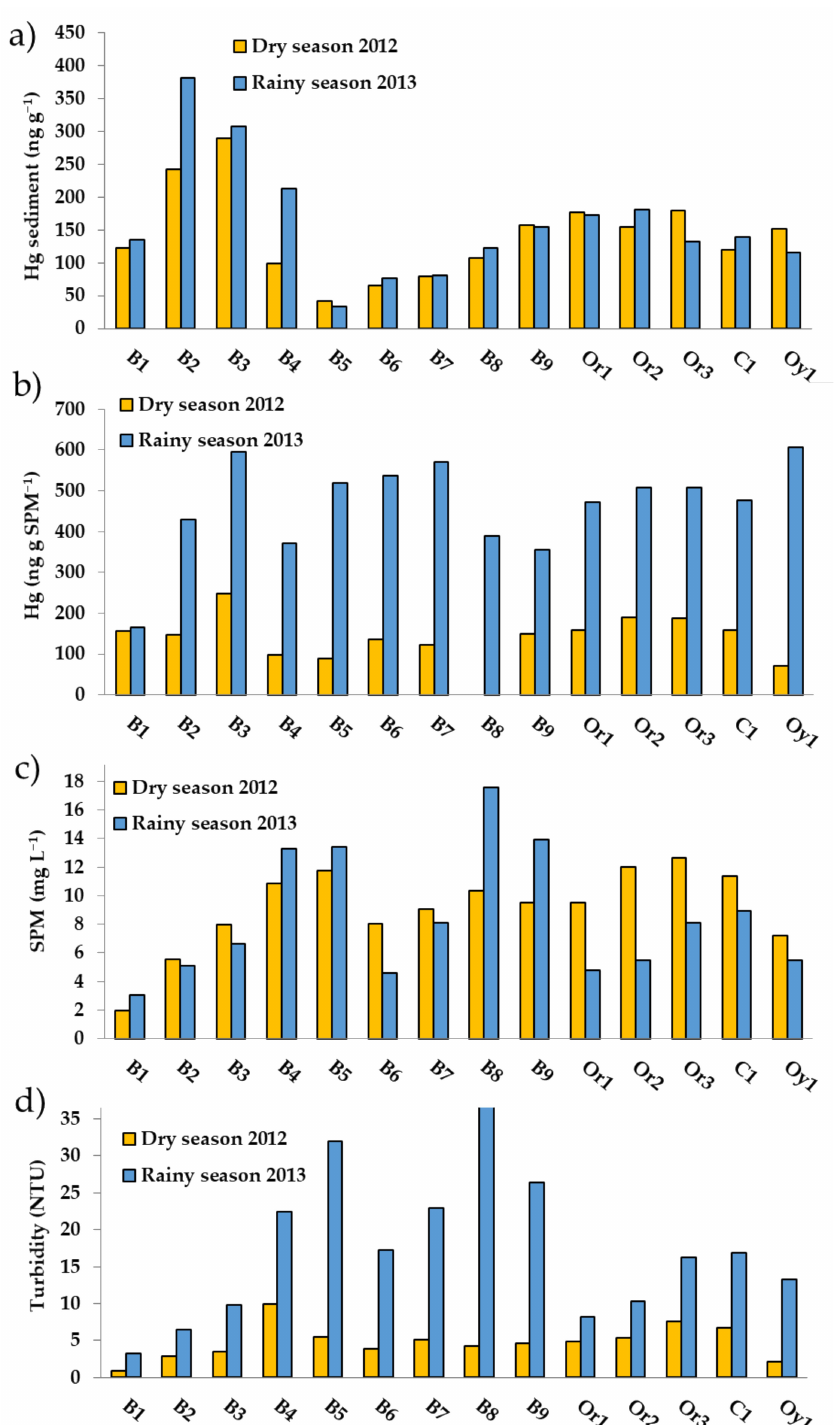
Figure 3. ( a ) Hg associated to river sediments, ( b ) Hg associated to suspended particulate matter (SPM), ( c ) suspended particulate matter (SPM) and ( d ) Turbidity at all sampling points for the dry season in September 2012 and the rainy season in March 2013. B1 to B9: Boulanger Creek, Or1 to Or3: Orapu River, C1: Comt é River and Oy1: Oyack